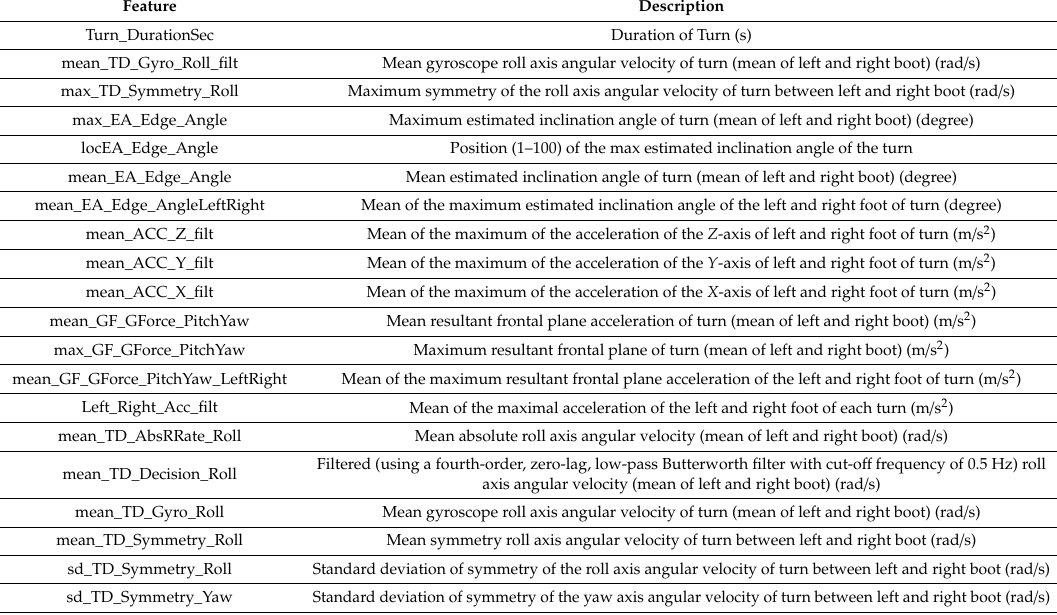
Table A3. List of features for snowplow and snowplow-steered turn prediction.